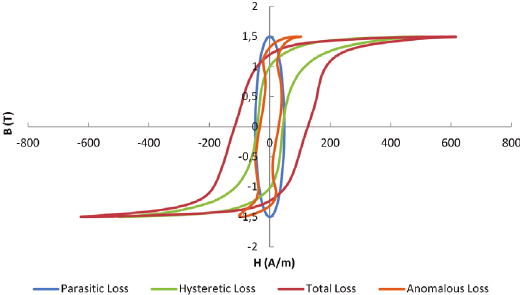
Figure 3. Loss separation for NO samples annealed for 4 hours at 850 °C with final grain size 58 µ m using peak induction 1.5 T and frequency 60 Hz.